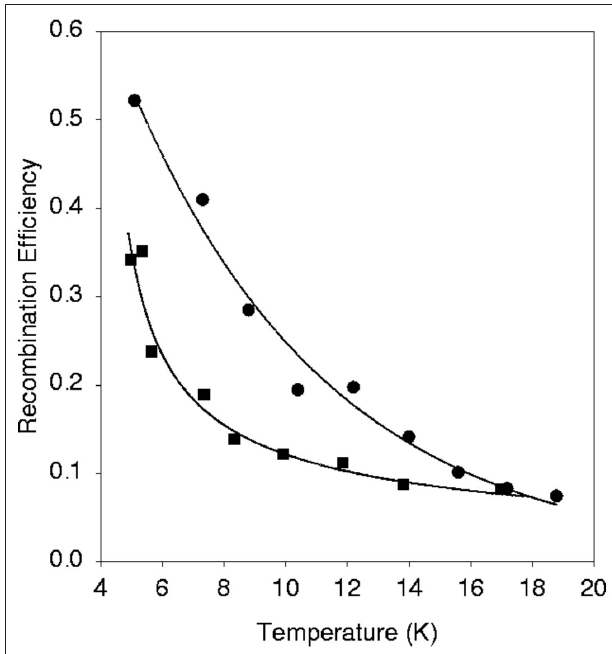
FIGURE 1 | HD recombination efficiency as a function of temperature on a surface of amorphous carbon grains ( top , filled circles) and crystalline olivine ( bottom , filled squares). Lines are guides to the eye. From Pirronello et al. (1999) , reproduced with permission from Astronomy & Astrophysics,